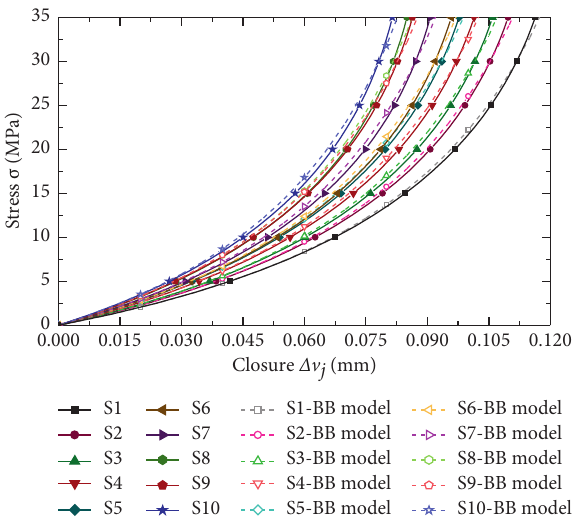
Figure 11: The fitting curves for stress-closure curves of joints S1–S10. Table 3: The parameters of stress-closure curve fitting equations.